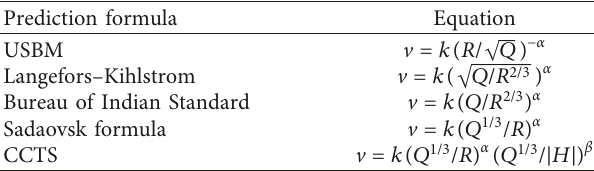
Table 1: Different vibration prediction formulas [4–7, 9]. Prediction